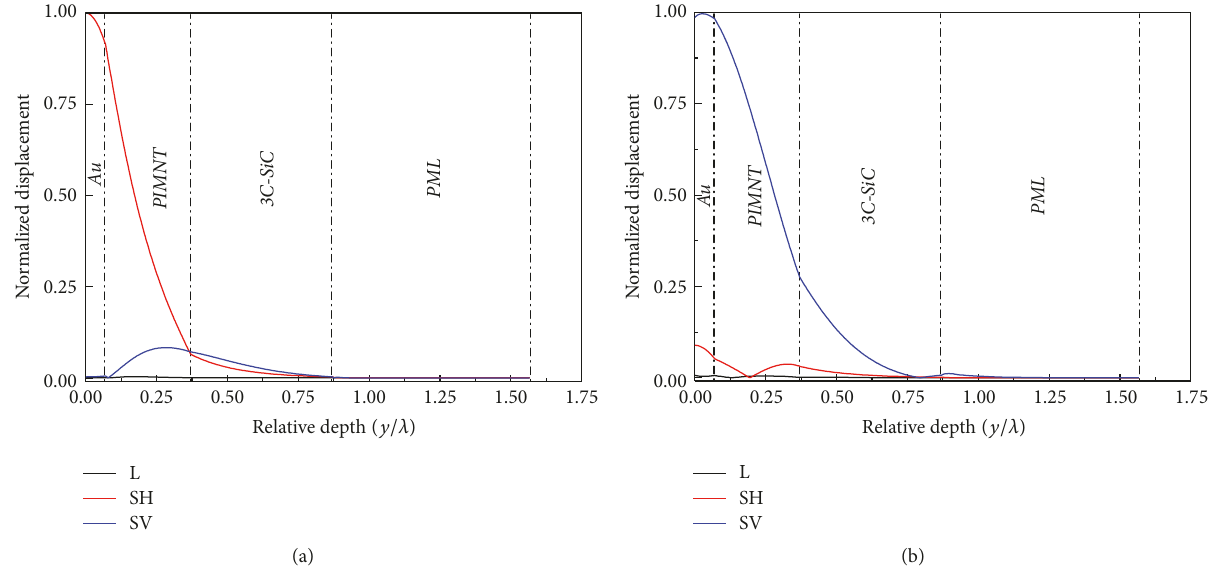
Figure 4: Normalized displacement field distribution for SH and Rayleigh SAWs on the layered structure: (a) SH SAW and (b) Rayleigh SAW.